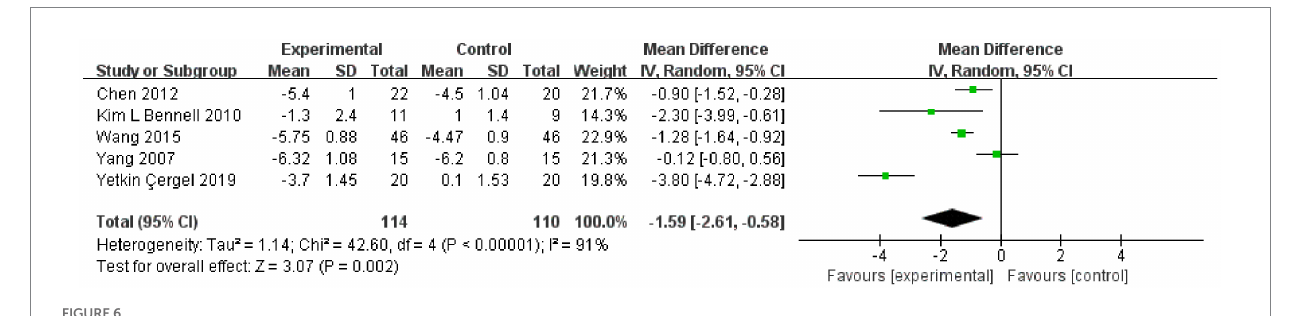
FIGURE 6 Forest plot for the VAS.